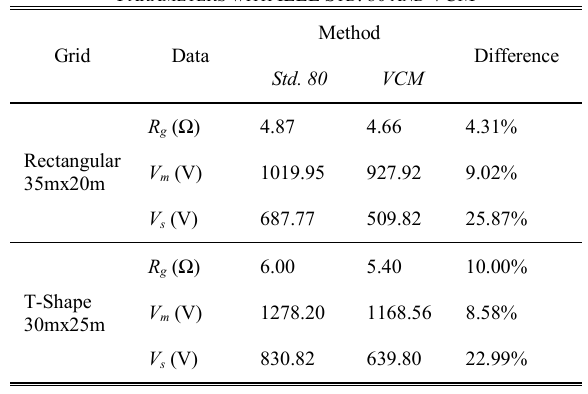
TABLE II P ARAMETERS WITH IEEE S TD . 80 AND VCM